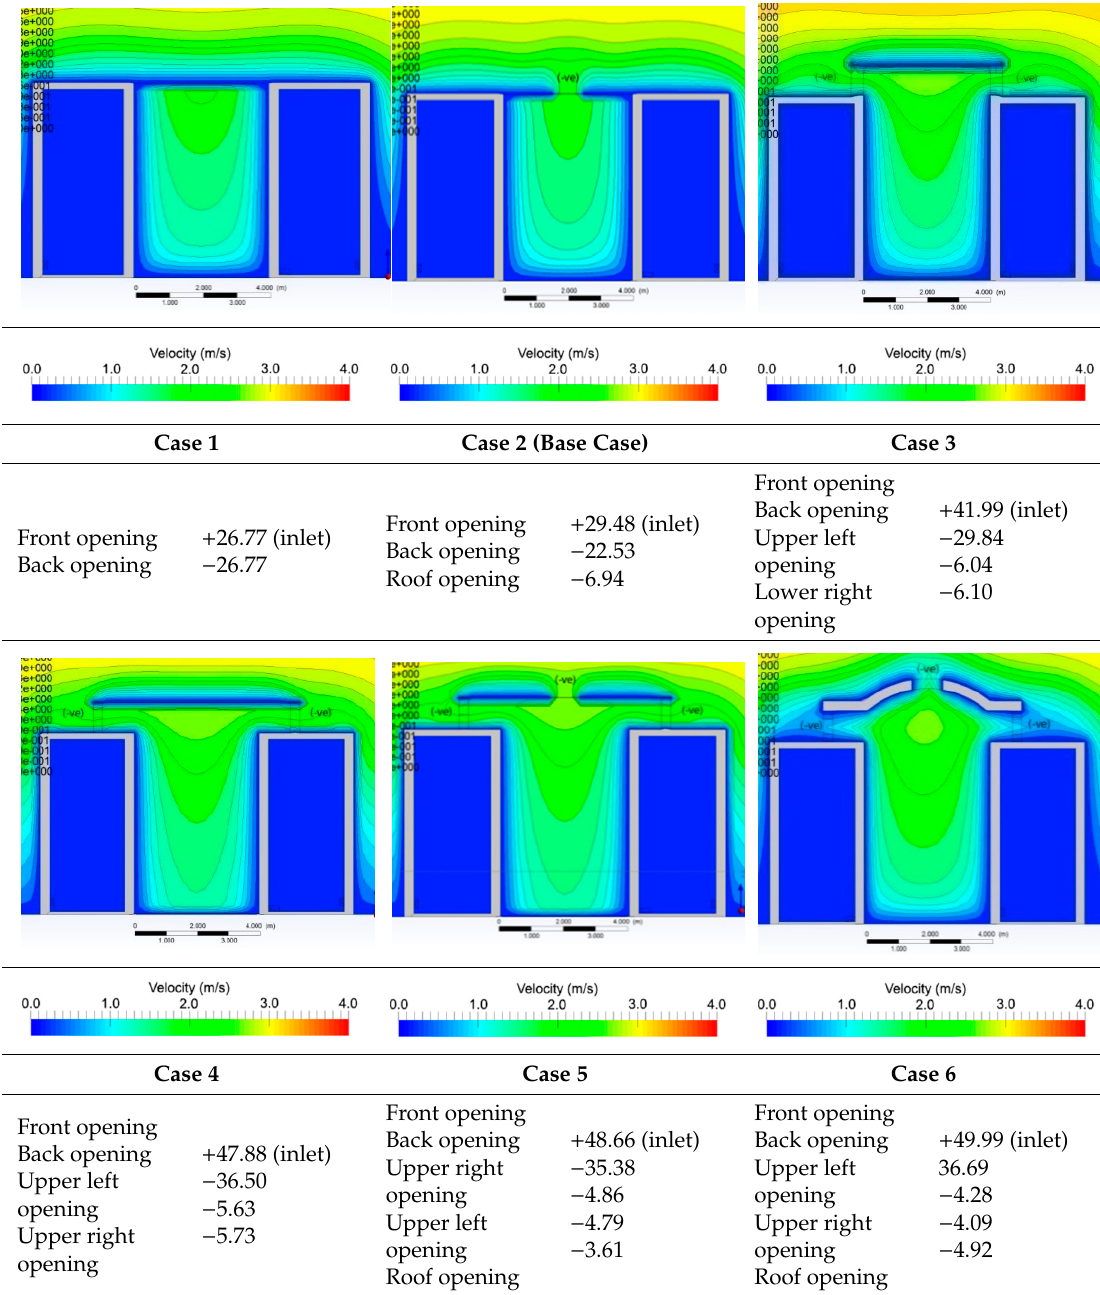
Table 7. Volumetric flow rate (Q) (m 3 /s) through the alley’s openings. Positive Q values refer to air entering (inlet) and negative values denote air leaving (outlet).